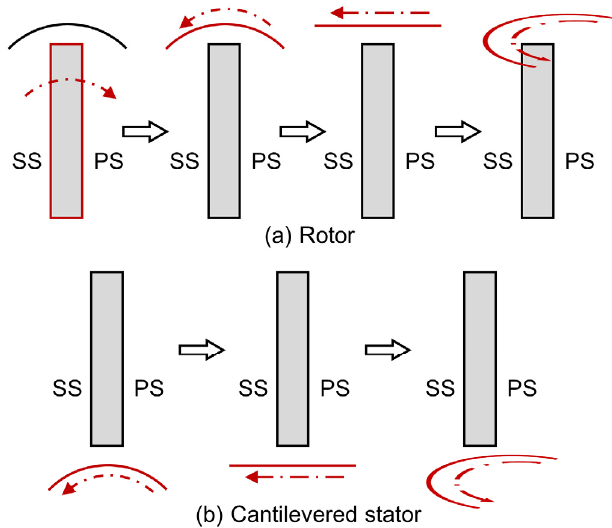
Figure 1. Simplification procedures for axial compressor rotor and cantilevered stator.